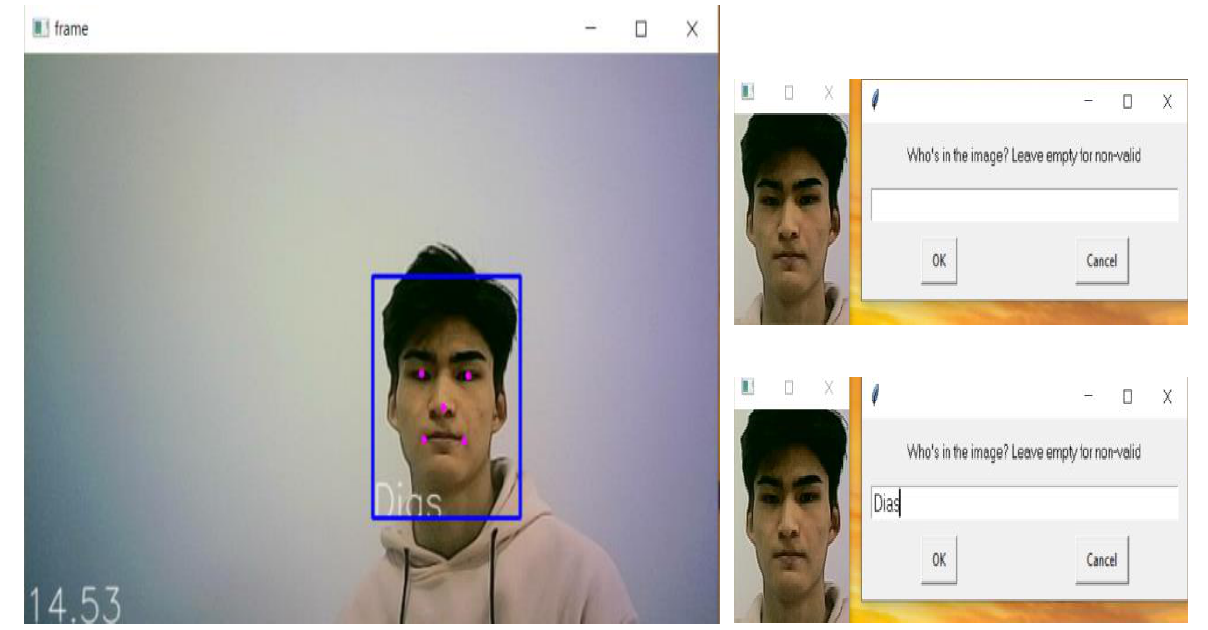
Figure 5. Creating a new